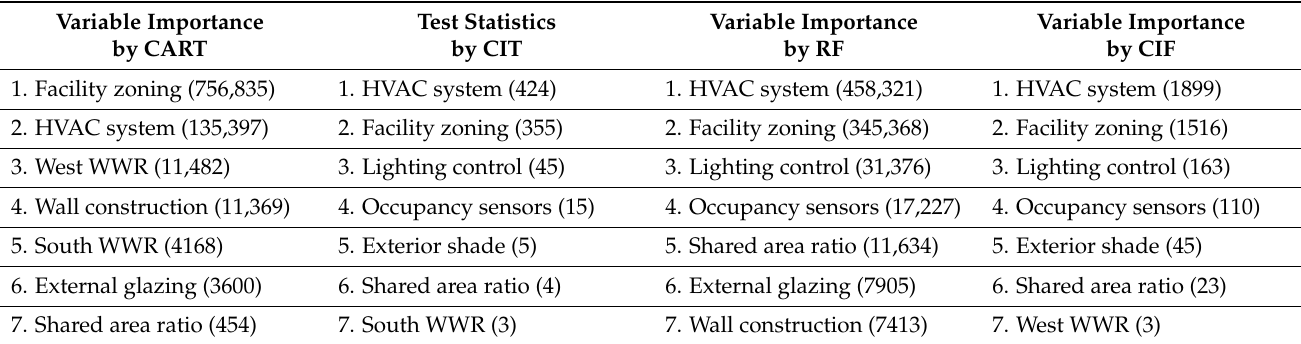
Table 7. Top seven important variables by algorithm.